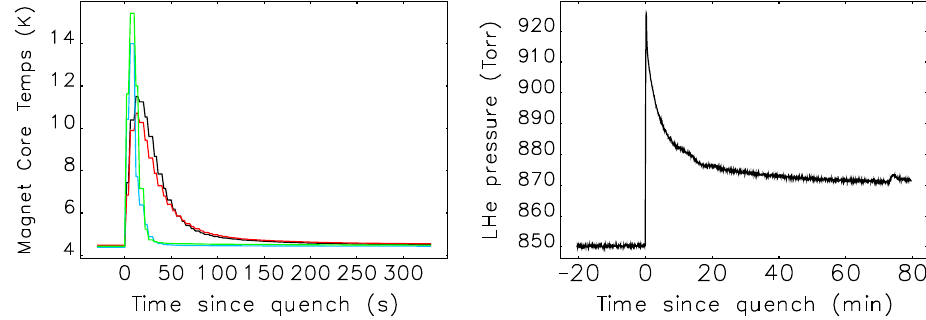
FIG. 17. Left panel: Magnet core temperatures after a quench measured by four temperature sensors on two magnet cores, shown in different colors. Right panel: Pressure variation in the liquid helium system shown for the same